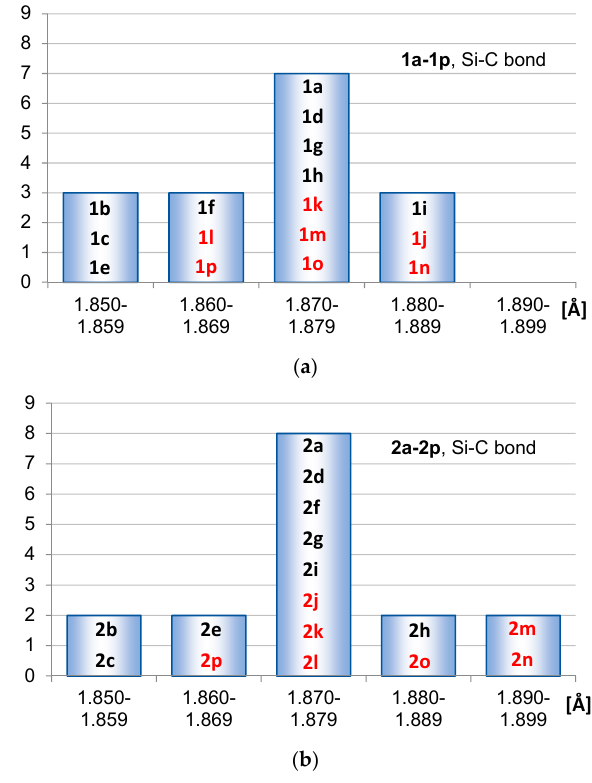
Figure 3. Distributions of SiC(ring) bond lengths of ( a ) 1a – 1p and ( b ) 2a – 2p calculated at PBE0/6-31G(d) level. The compound numbers substituted at the Si atoms are displayed in black and those substituted at the C atoms in red.